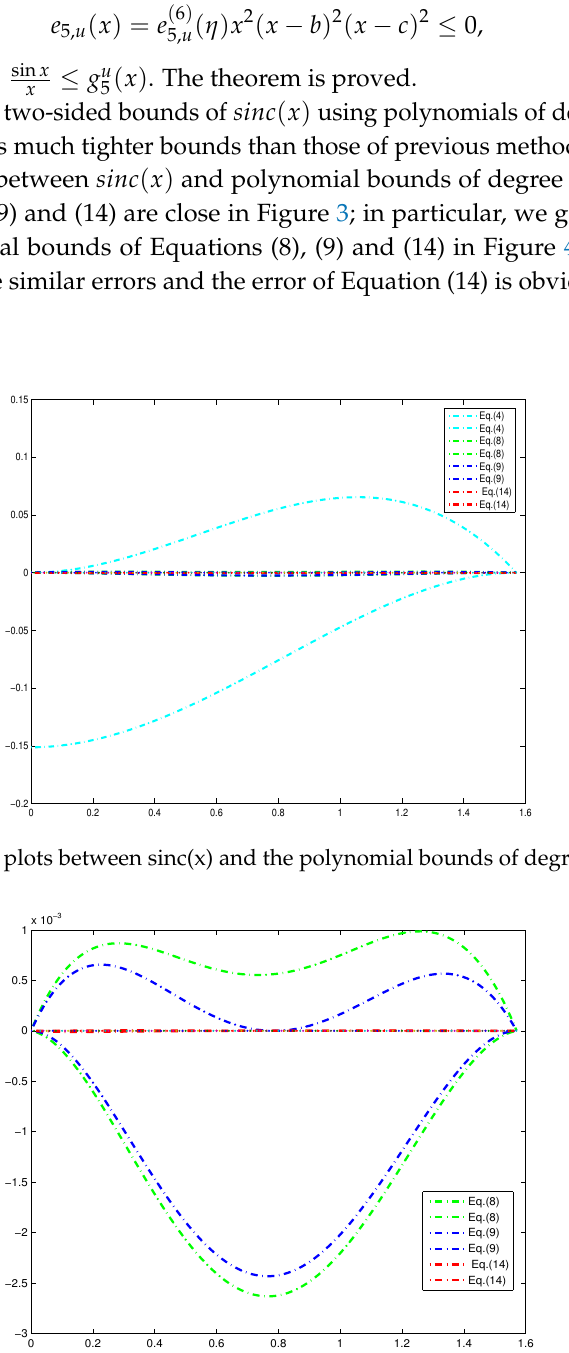
Figure 4. Error plots between sinc(x) and the polynomial bounds of Equations (8), (9) and